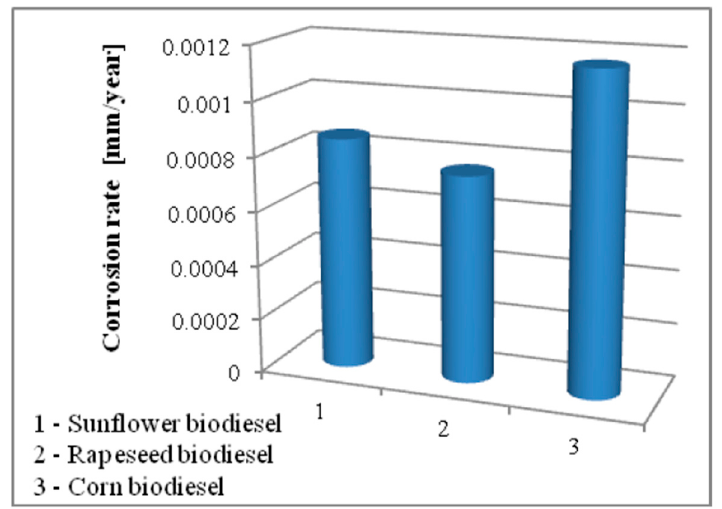
Figure 6. CRs of carbon steel in three different biodiesels [63].